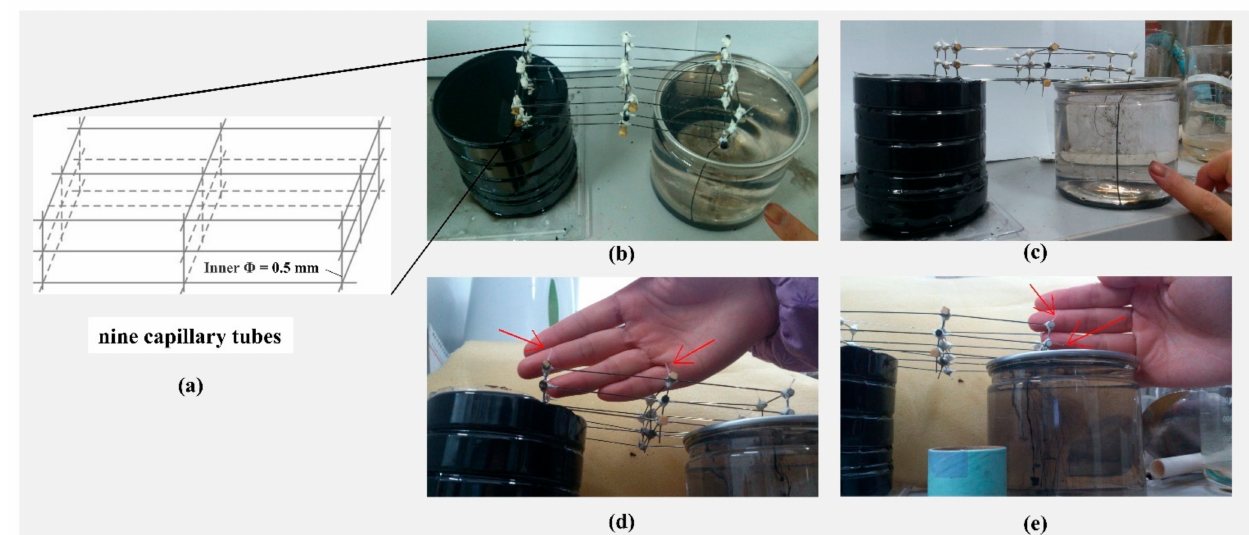
Figure 7. ( a ) Schematic diagram of nine capillary tubes; ( b – e ) the capillary bundle siphon